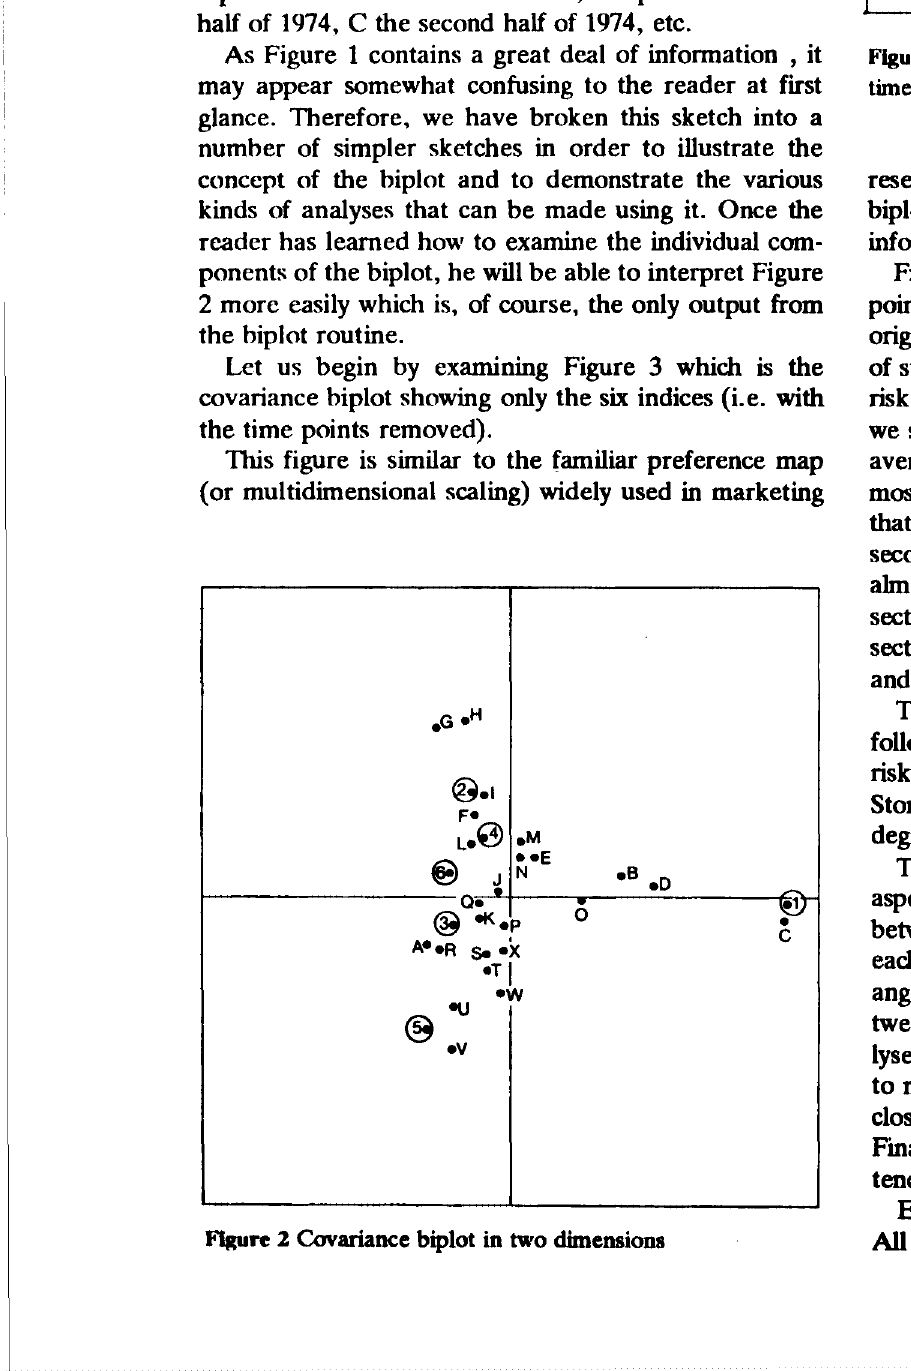
Figure 3 Covariance biplot showing only the six indices with the time points